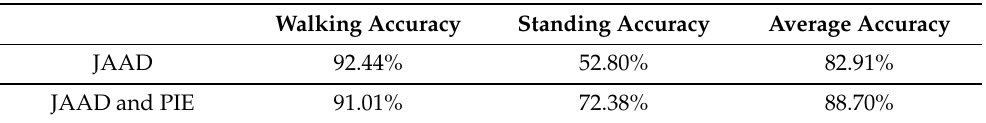
Table 4. Test accuracy of pedestrian-action recognition using the conventional dense SIFT flow two-stream CNN.